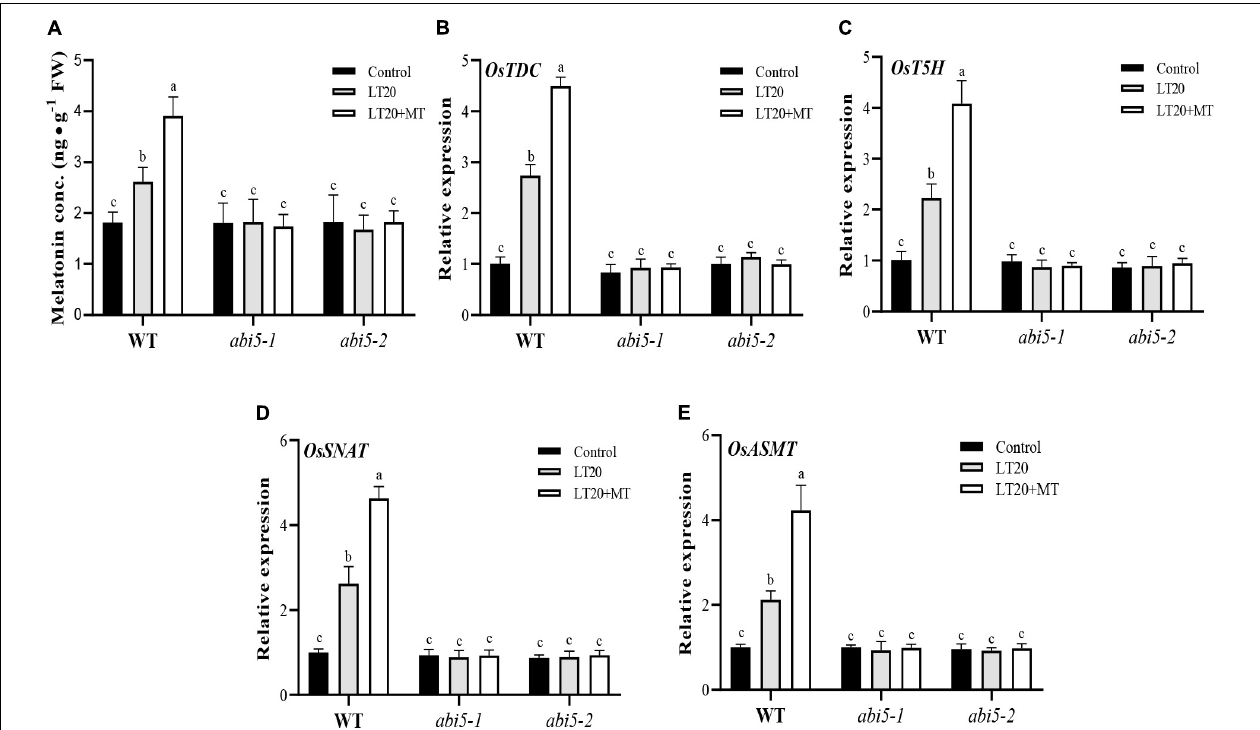
FIGURE 6 | Effects of exogenous MT treatment on the biosynthesis of endogenous MT under LT. (A) Endogenous MT content and (B–E) transcript abundance of MT biosynthesis genes ( TDC , T5H , SNAT , and ASMT ) under LT stress (constant 20 ◦ C for 7 days) without (LT20) or with (LT20 + MT) MT treatment in WT and abi5 mutants. Different letters denote significant variations between the treatments, and the average values were measured by Tukey’s HSD test at p < 0.05. Data were represented as mean ± SE of six biological